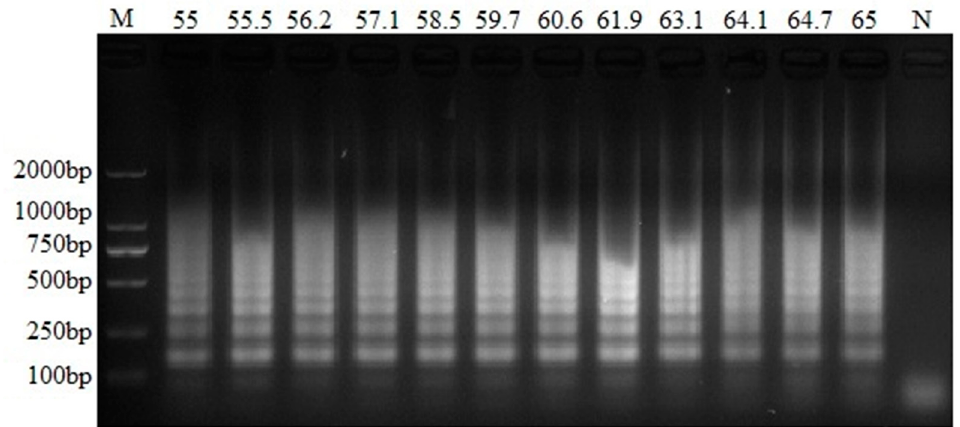
Figure 1. Optimal temperature of the RT-LAMP assay for PEDV. The same reaction mixtures were incubated at different temperatures (55 °C, 55.5 °C, 56.2 °C, 57.1 °C, 58.5 °C, 59.7 °C, 60.6 °C, 61.9 °C, 63.1 °C, 64.1 °C, 64.7 °C and 65 °C). The results were detected by 2% ( w / v ) agarose gel electrophoresis. Lane M: DL2000 DNA marker; Lane N: negative control.